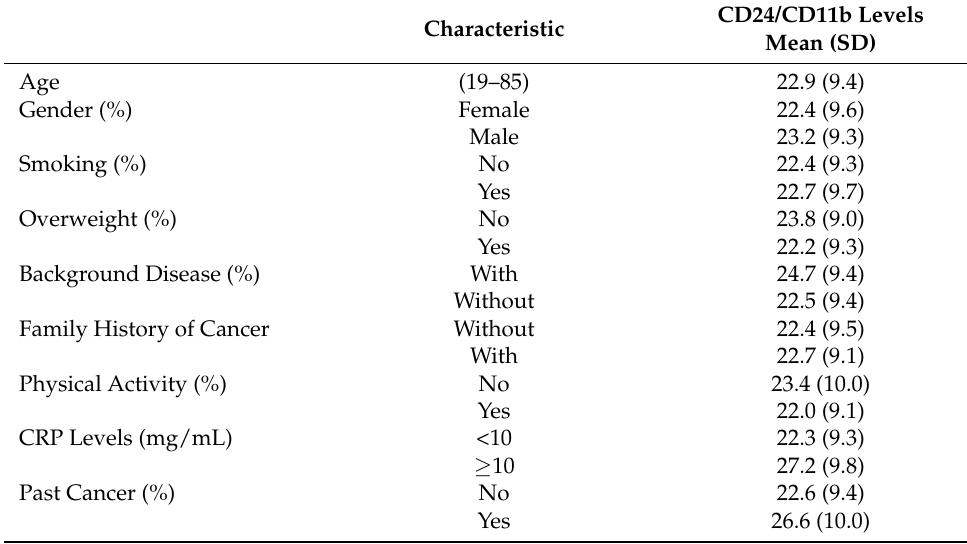
Table 2. CD24/CD11b levels of study participants across the different measurements.